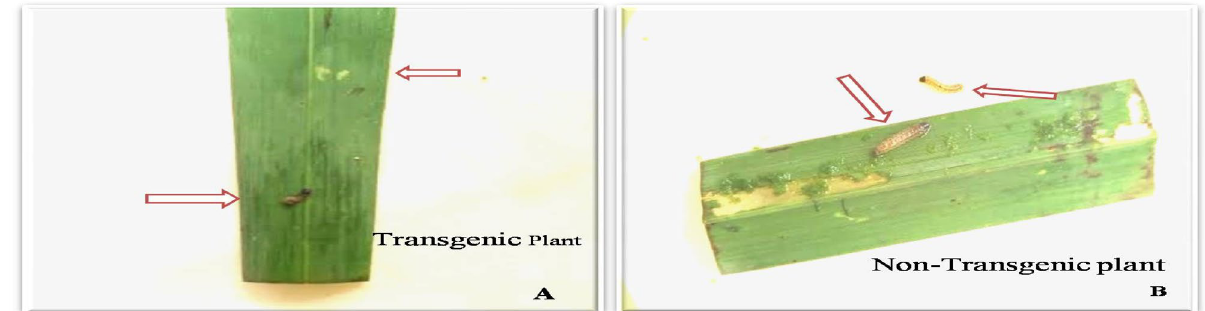
Figure 10. Leaf bioassay of 80 days old transgenic and non transgenic sugarcane. Plate ( A ) Transgenic sugarcane leaves killed Chilo infuscatellus larvae. Plate ( B ) Non-transgenic sugarcane plant. Chilo infustcatellus , alive and actively